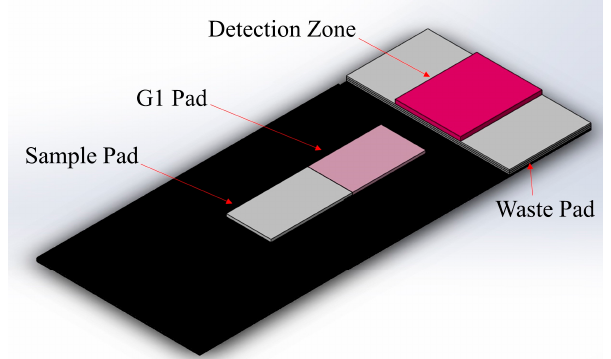
Figure 2. Device uses a simple mechanical folding architecture where the detection zone folds over the G1 pad. This provides the required delay step for nitrate to reduce to nitrite and allows for a uniform color formation in the detection zone. The G1 pad was either a strip of Zinculose for nitrate detection or chromatography paper (CHR1) for nitrite detection.